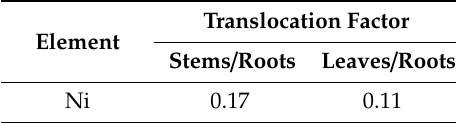
Table 4. The translocation factor (TF) of Ni in A. puber .